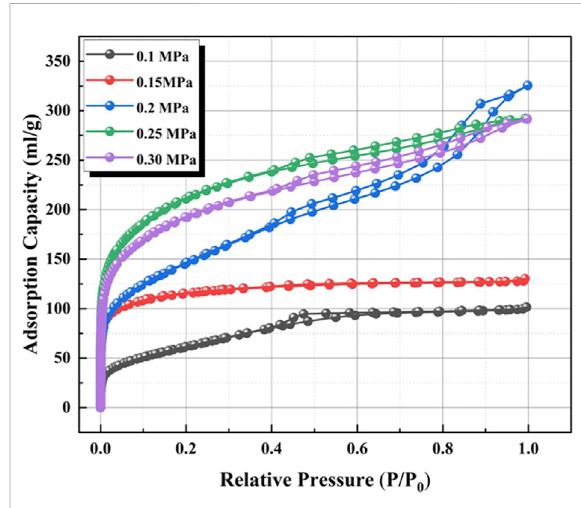
FIGURE 3 Nitrogen adsorption and desorption isotherms of the as- obtained honeycomb silica gel using water glass as the starting material at different CO 2 pressures.